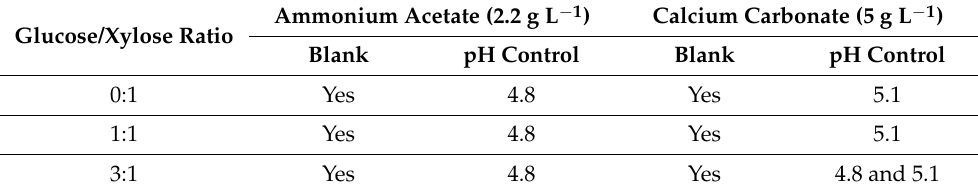
Table 1. Experimental plan with batch mode. The value of pH control indicates the minimum pH reached.